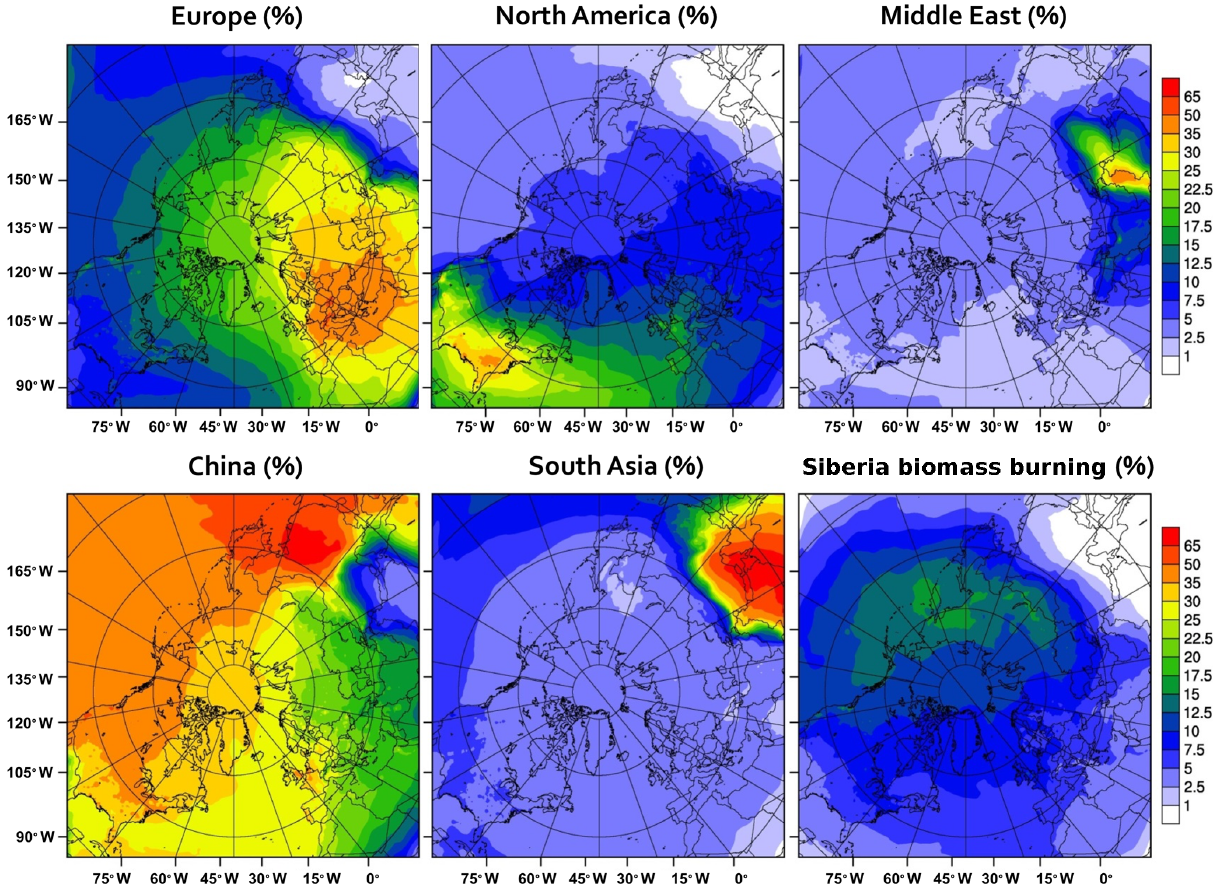
Figure 11. Spatial distribution of source region contributions (%) to annual BC surface concentration over the entire domain. This figure is generated using NCAR Command Language (NCL) version 6.3.0, open-source software free to the public, by UCAR/NCAR/CISL/TDD, http://dx.doi.org/10.5065/D6WD3XH5